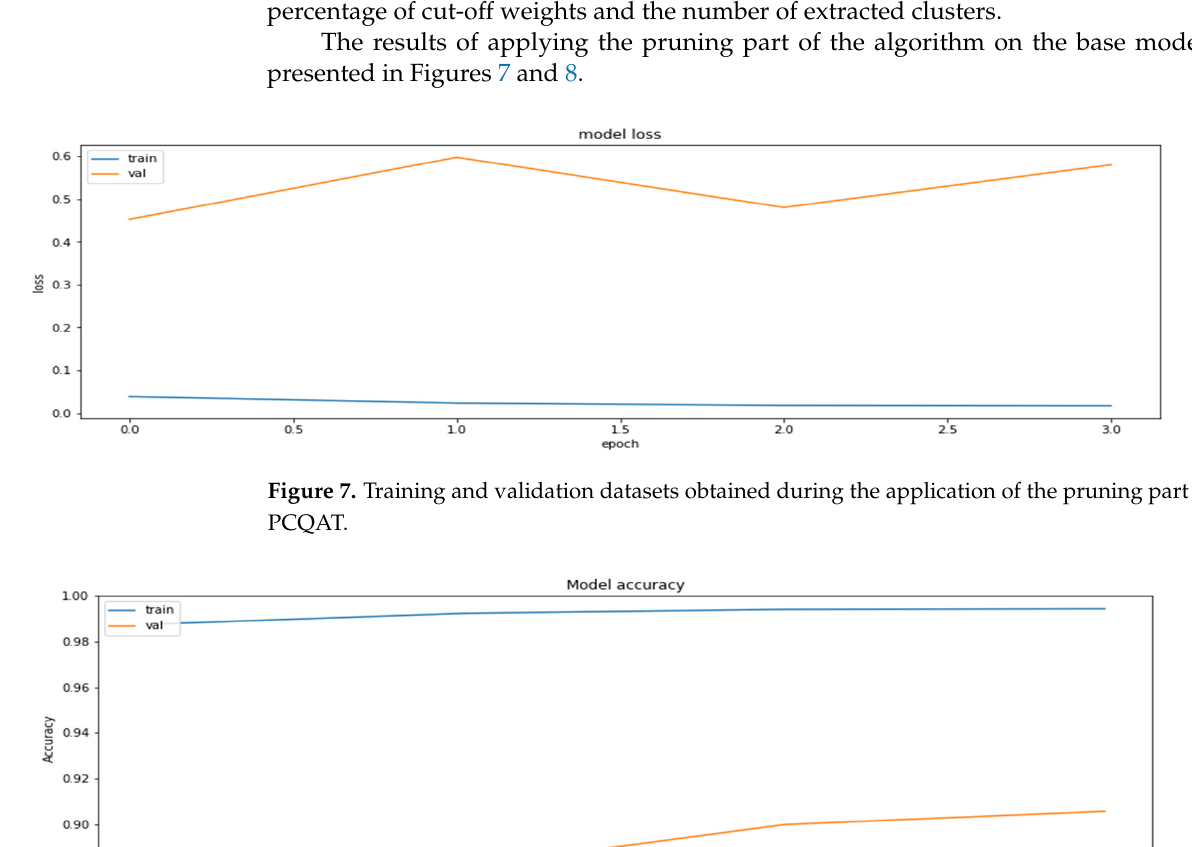
Figure 10. Training and the validation datasets obtained during the application of the weight clustering part of the PCQAT. Finally, QAT was applied on the weight-clustered model, and sparsity-preserving and cluster-preserving flags were set in order to maintain the compression achieved by previous methods. The results of the training of this part of the algorithm are shown in Figures 11 and 12.